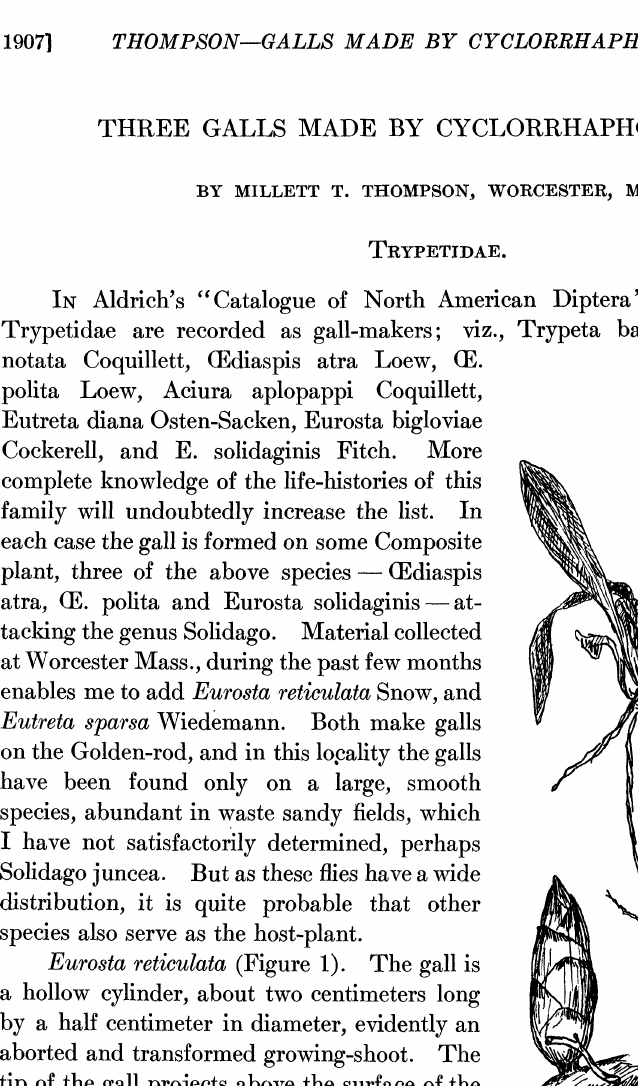
Figure 1, Gall of Eurosta